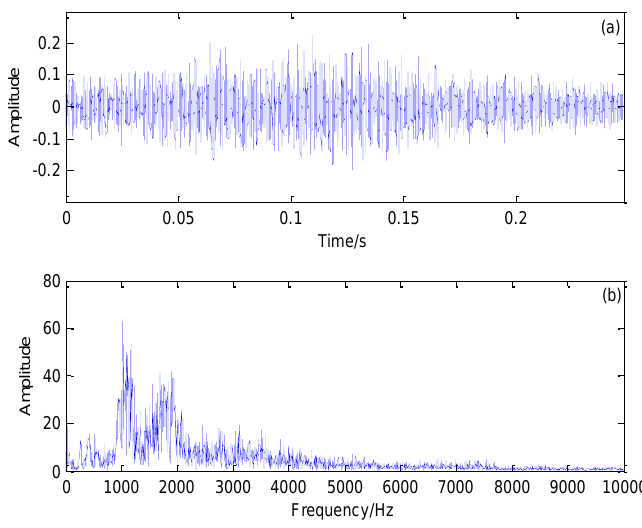
Figure 14. Outer race fault signal of the locomotive bearing under the loading of 1 t: ( a ) time domain signal and ( b ) its